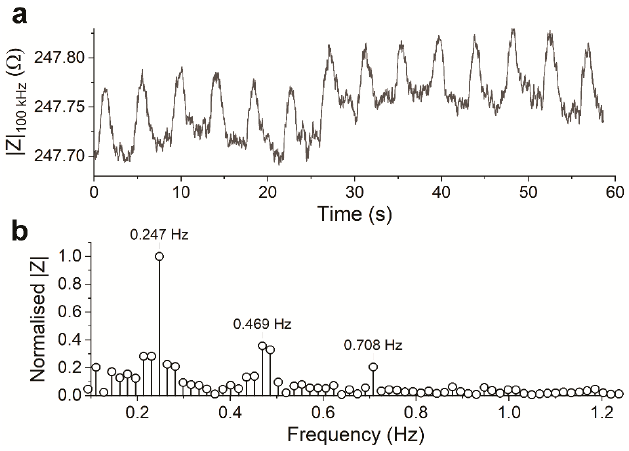
Figure 5. ( a ) The magnitude of the recorded impedance of the contractile hPSC-CMs, recorded by Pt wires in the well-plate setup, plotted over time. ( b ) Frequency components of the recorded magnitude data shown in (a).